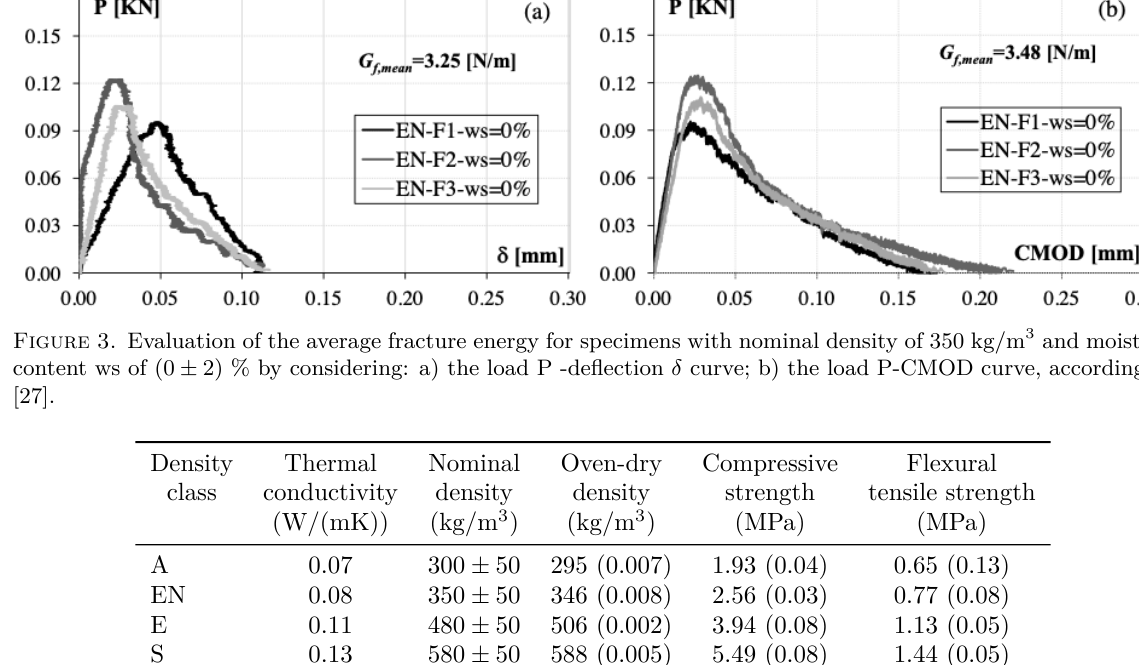
Table 1. Properties of AAC specimens for di ff erent density classes, with (6